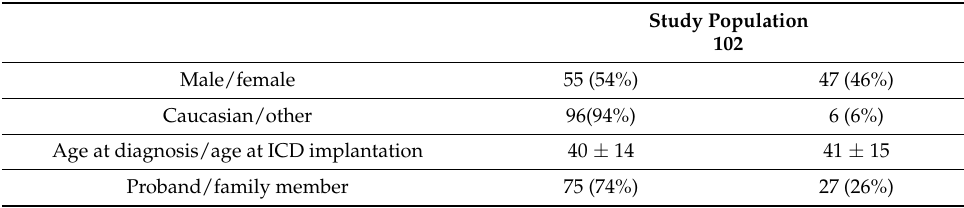
Table 2. Demographic characteristics of the study population.